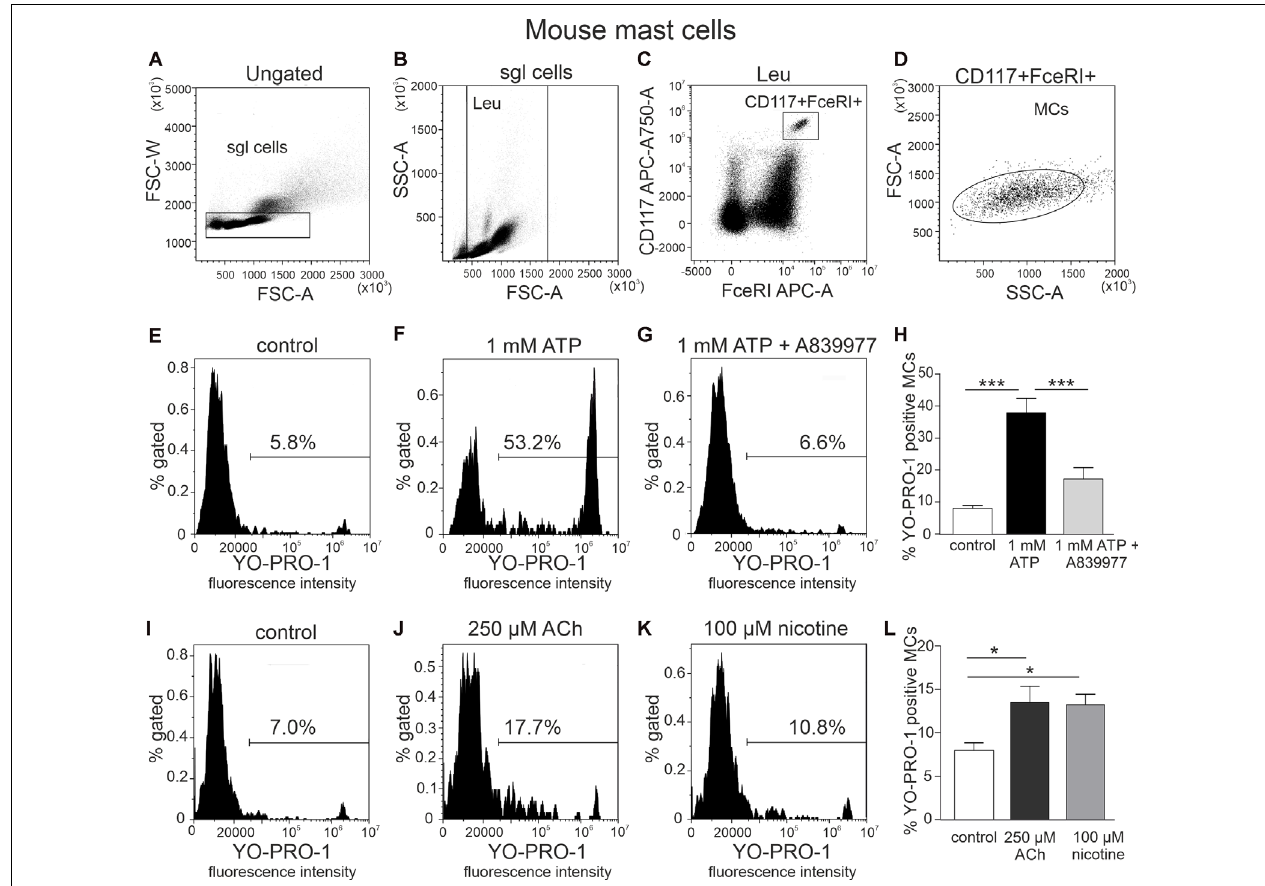
FIGURE 1 | Flow cytometric gating strategy for identification of mast cells and testing action of ATP, acethylcholine, and nicotine on the YO-PRO1 uptake by peritoneal mast cells. (A) Single cells gating based on FSC-A vs. FSC-W (the “sgl cells” region is set to discriminate cell doublets). (B) Light scatter dot plot for cells based on forward scatter (FSC-A) and side scatter (SSC-A) [leucocyte (Leu) region is set to discriminate debris]. (C) Cell subpopulations based on Alexa Fluor 647-Fc ε RI and APC-Cy7-CD117 (the region is set to identify double-positive cells). (D) Backgating of double-positive cells onto the light scatter plot FSC-A vs. SSC-A. This shows relative size and granularity of mast cells compared to those in (B) . Cells from the region of “mast cells” were further used to assess the effects of ATP, acetylcholine, and nicotine. (E–G,I–K) Representative histograms (fluorescence intensity vs. percent of gated mast cells) of YO-PRO1 uptake by mast cells. (E,I) Negative control [treated with phosphate-buffered saline (PBS)], mouse peritoneal mast cells incubated with 1 µ M of YO-PRO. (F) Mast cells incubated with 1 mM of ATP for 20 min. (G) Mast cells preincubated with P2X7 antagonist A839977 (5 µ M), followed by stimulation with 1 mM ATP. (H) Histograms showing percent of YO-PRO1-positive cells in control (white, n = 12), after stimulation with 1 mM ATP (black, n = 12) and in the presence of the P2X7 antagonist A839977 (5 µ M; gray, n = 9). (J) Mast cells incubated with 250 µ M acetylcholine. (K) Mast cells incubated with 100 µ M nicotine. (L) Histograms showing percent of YO-PRO1-positive cells in control (white, n = 12), after stimulation with 250 µ M acetylcholine (black, n = 5) and 100 µ M nicotine (gray, n = 5). Mean ± SEM, * p < 0.05, *** p < 0.0001 (one-way ANOVA, followed by Bonferroni’s multiple comparison test).